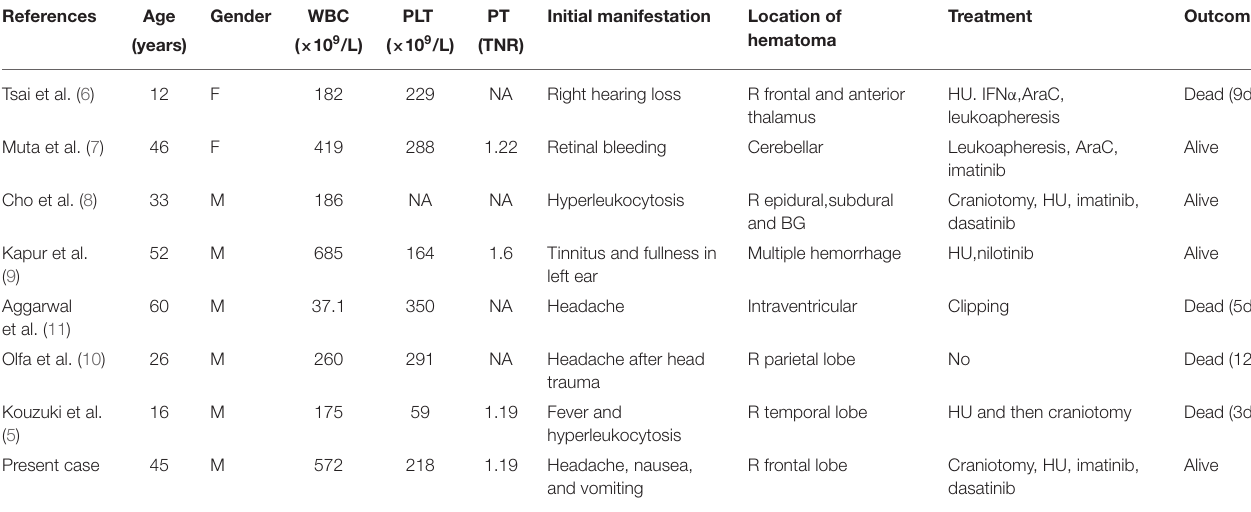
TABLE 1 | Reported cases of CML with ICH in Chronic